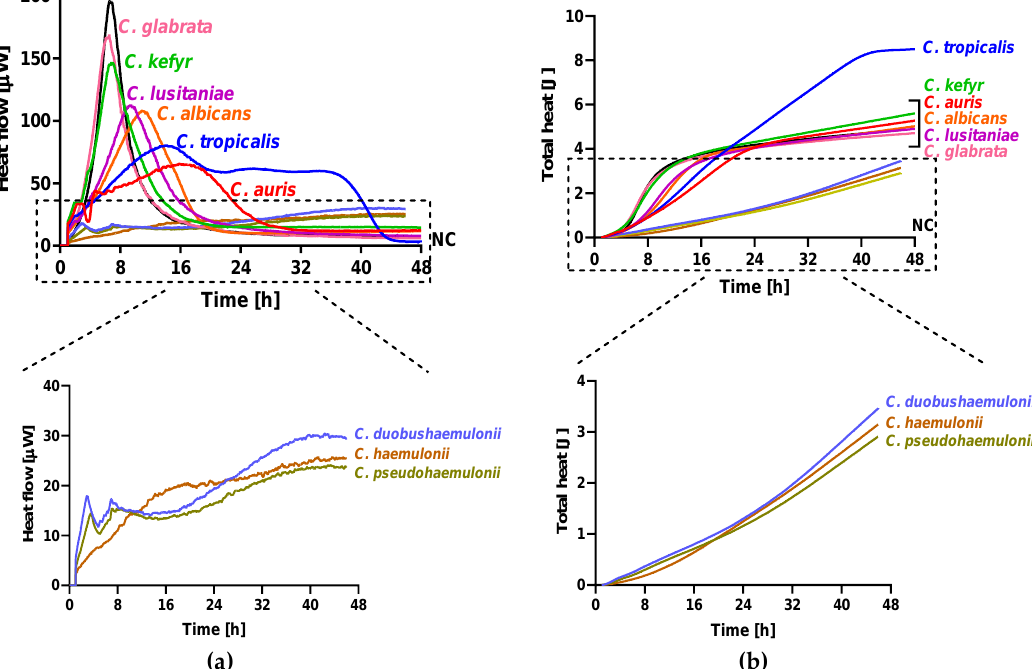
Figure 1. Microcalorimetry analysis of Candida spp. Heat flow ( a ) and total heat ( b ) curves generated by planktonic C. parapsilosis , C. glabrata , C. kefyr , C. lusitaniae , C. albicans , C. tropicalis , C. auris , C. duobushaemulonii , C. haemulonii , and C. pseudohaemulonii in RPMI 1640 at 37 °C. Table 2. Microcalorimetric parameters of planktonic Candida